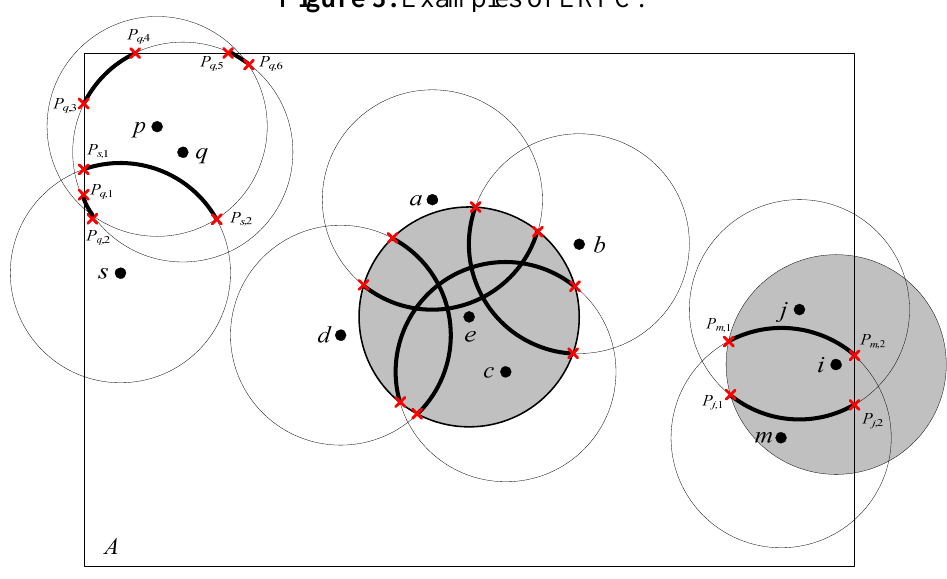
Figure 3. Examples of